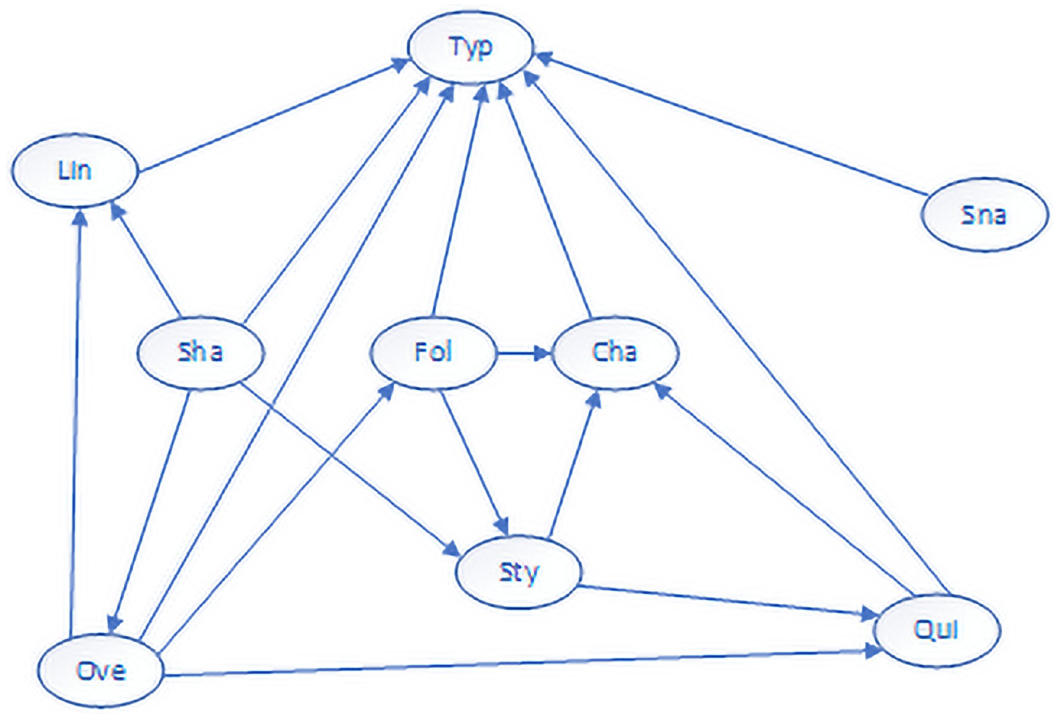
Fig 7. Bayesian network structure diagram.